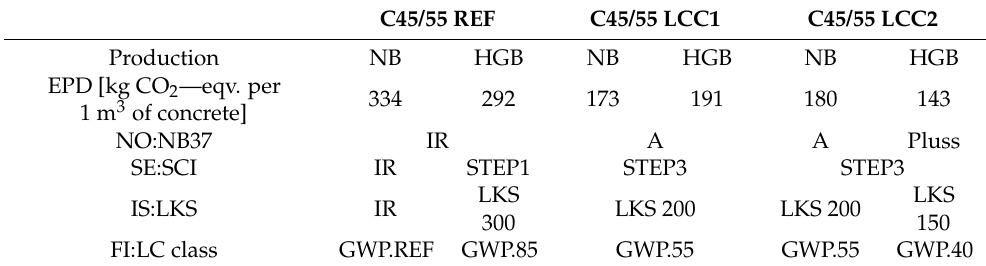
Table 9. Classification of demonstration series according to LCC guidelines of NO, SE, IS, and